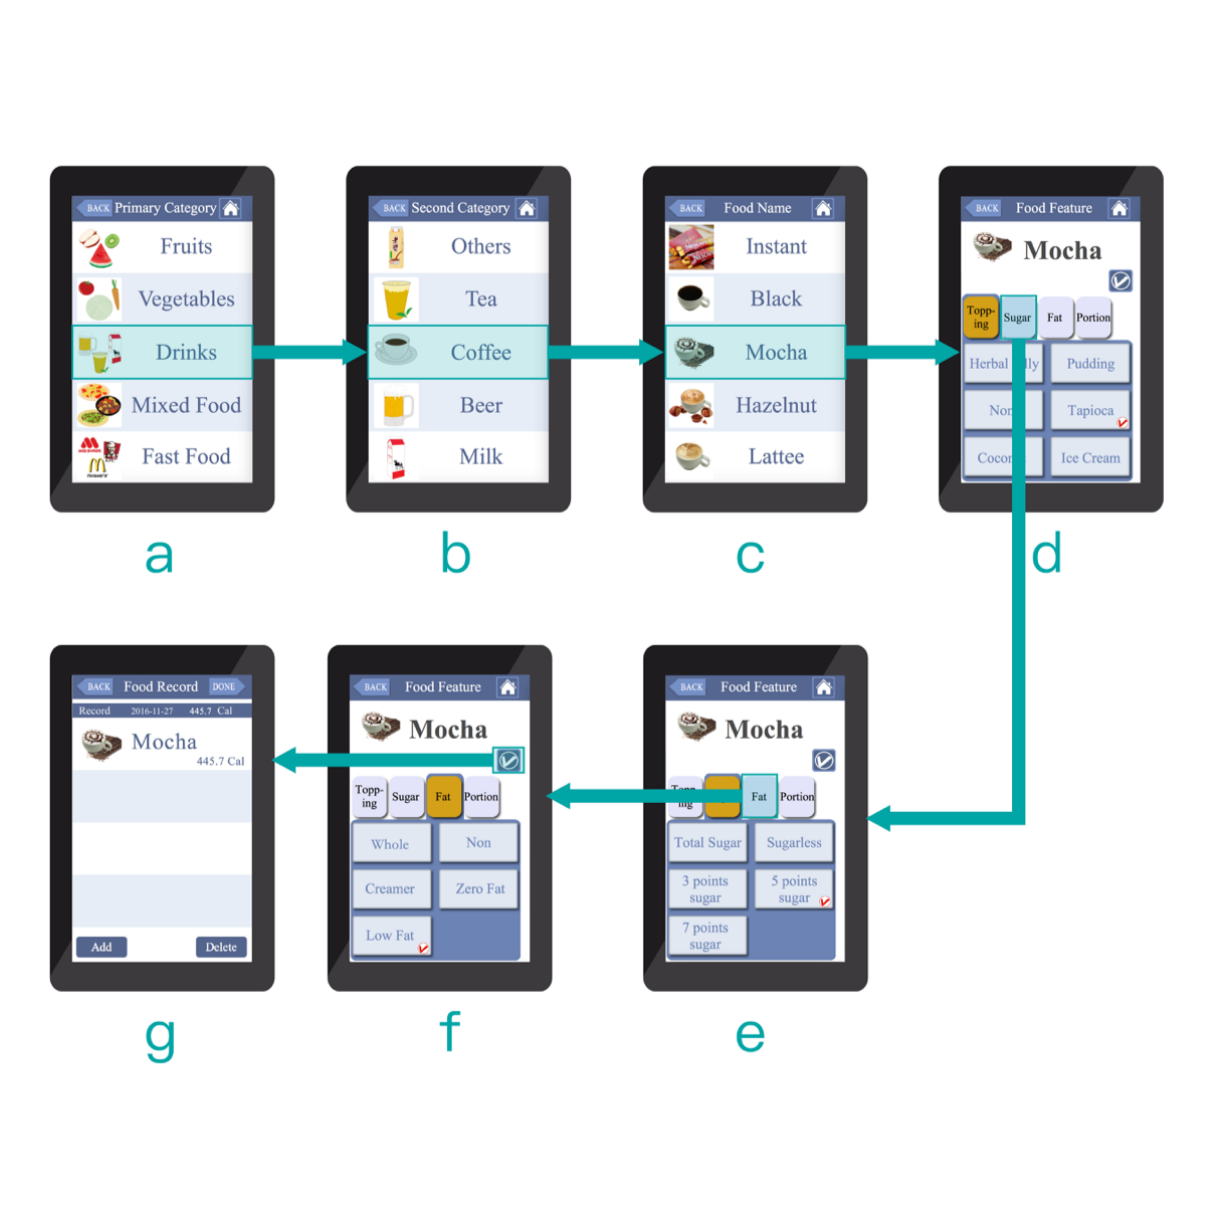
Figure 1. The self-chosen tab interface design and